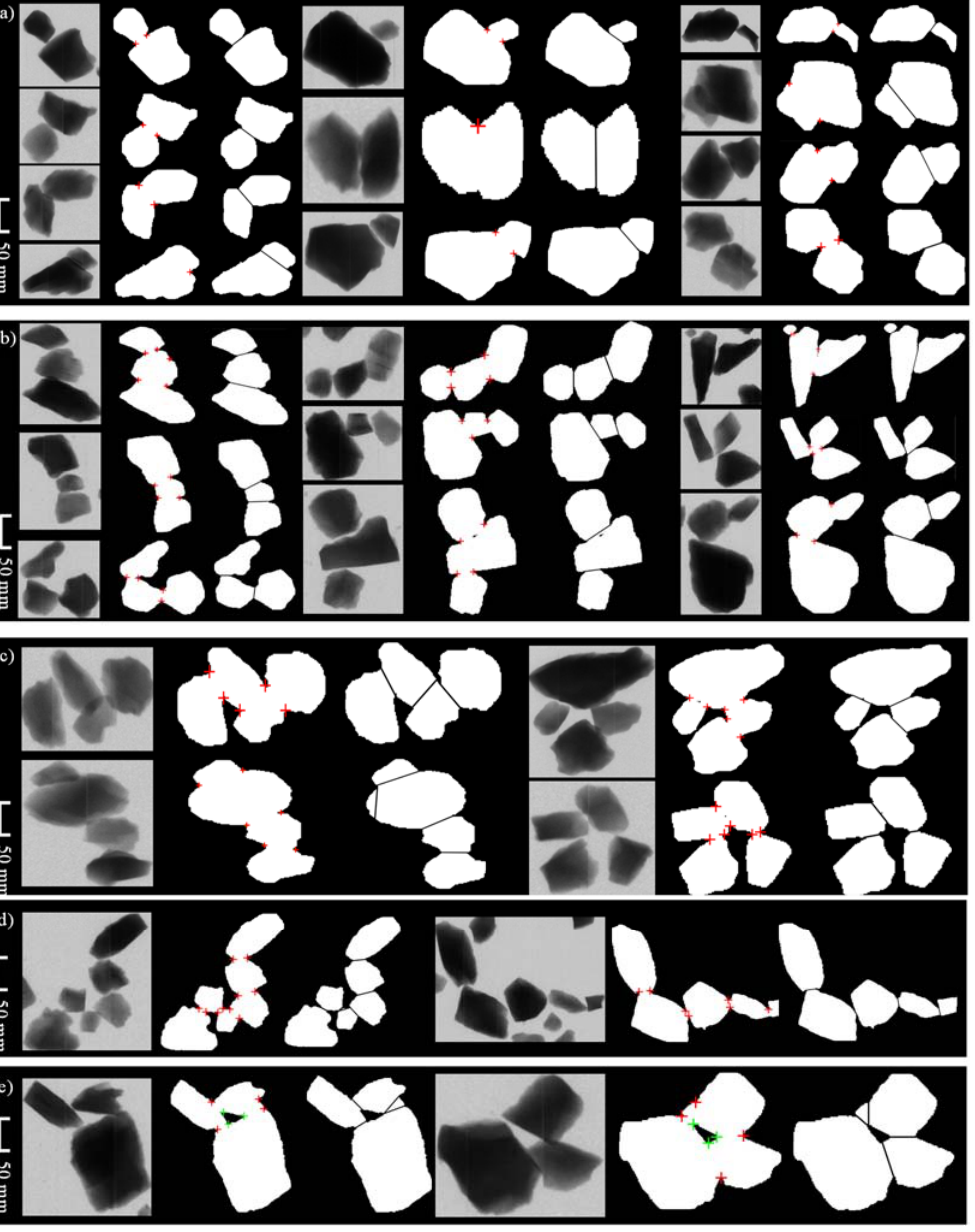
Figure 14. Results of pit detection and segmentation: ( a ) Two adhesions, ( b ) Three adhesions, ( c ) Four adhesions, ( d ) More than four adhesions, ( e ) CLA. A bright green “+” indicates more detected pits in the CLA target.